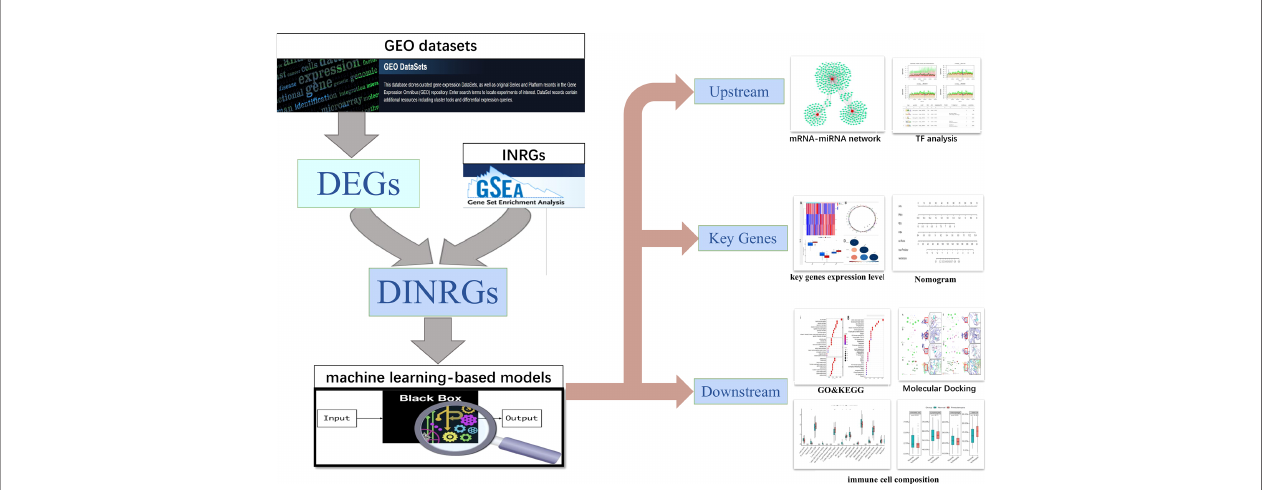
FIGURE 1 | Study fl owchart. GEO datasets, Gene Expression Omnibus datasets; DEGs, differentially expressed genes; INRGs, In fl ammatory response-related genes; DINRGs, differentially in fl ammatory response-related genes; TF, transcription